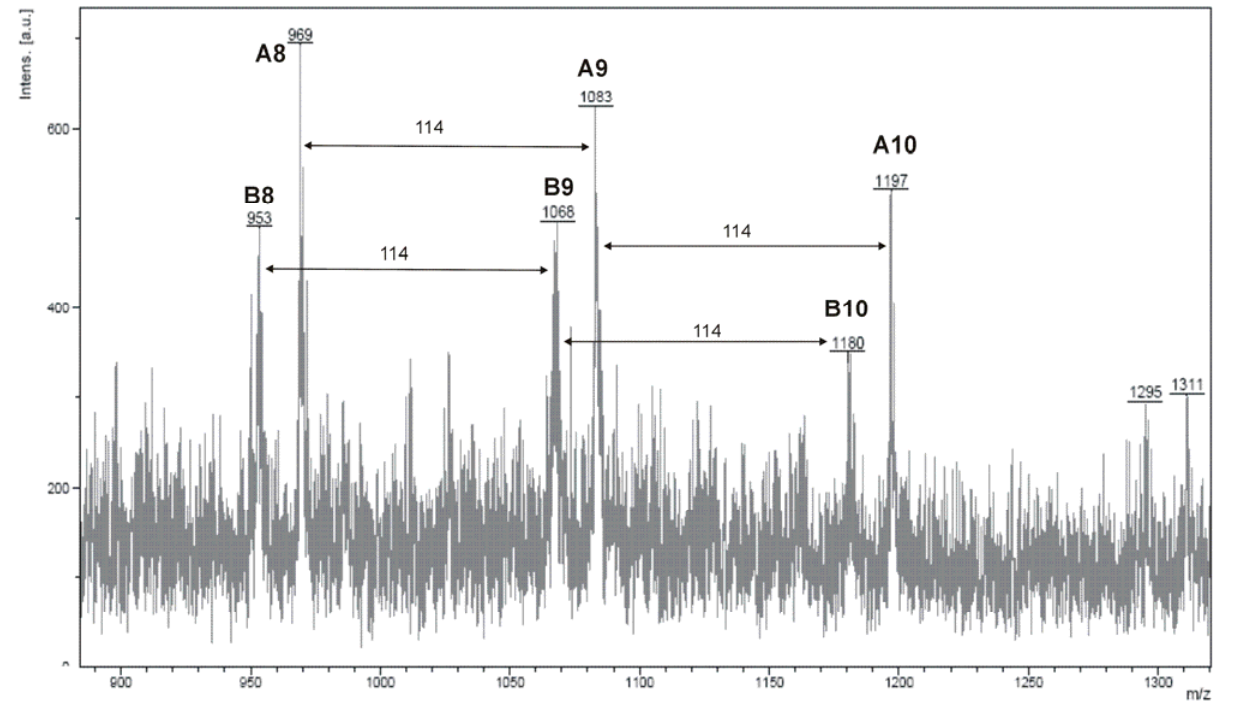
Figure 3. MALDI TOF spectra of the product of CL polymerization in the